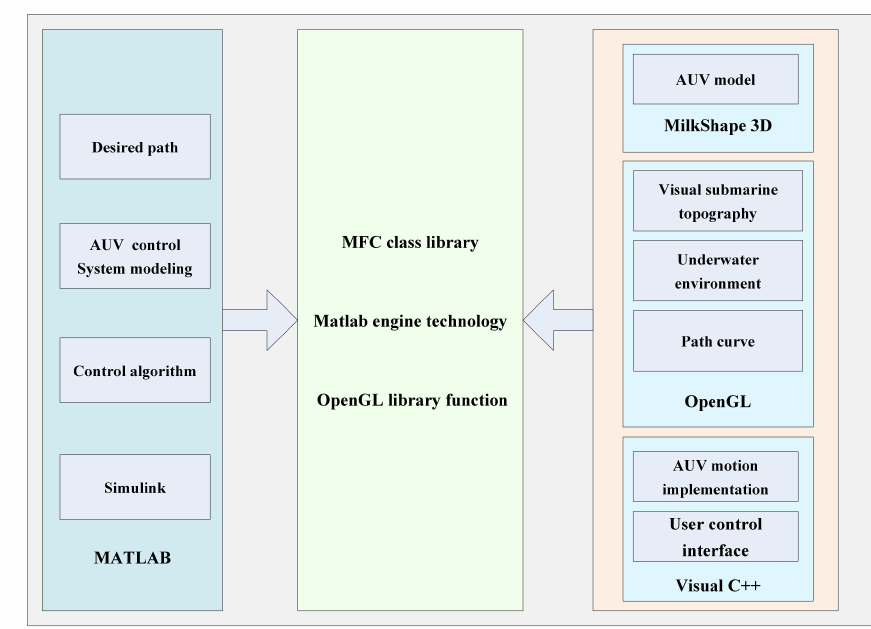
Figure 8. The framework of the AUV motion control VR